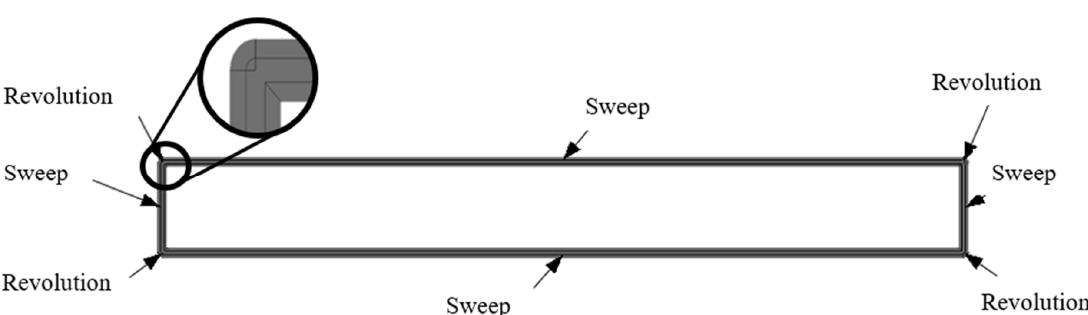
Figure 5. Line-by-line modelling with corner revolutions.